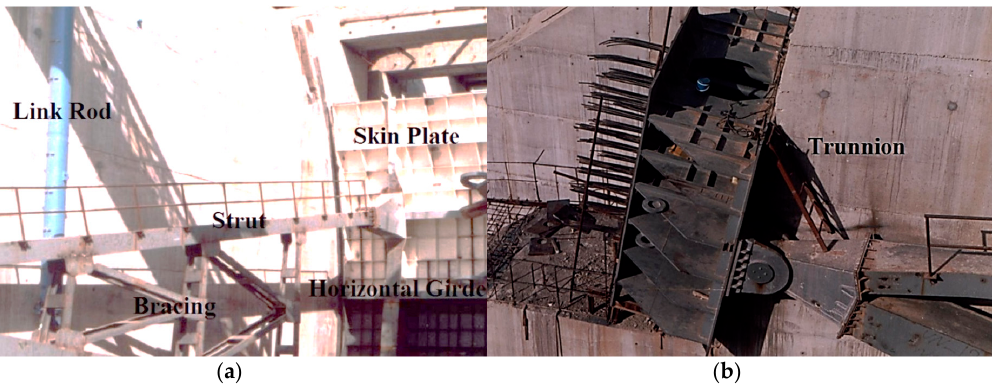
Figure 2. Primary radial gate components of Karkheh Dam ( a ) truss and skin plate, ( b ) trunnion beam. Karkheh dam spillway has six radial gates, each 15 m width with a height of 18.29 m (209 m above sea level); constructed generally for flood control with an overall discharge 18,700 m 3 /s. The structural dimensions of a spillway gate including width, height, skin plate radius, and the location of trunnions have been designed according to specific principles. The location of trunnions has an important function to resist hydrostatic forces. To maintain spillway stability, it is recommended that the hydrostatic resultant force applied to a radial gate possess either horizontal or downward direction to minimize overturn force. Mounting trunnions at one-third radial gate’s height make the direction of resultant force toward the gate horizontal. In general terms, the resultant force tends to be downward for lower trunnion locations. Accordingly, the trunnion locations are recommended to be one-third or half of the radial gate height. Additionally, the skin plate radius has an oppositional relationship with the weight of the gate. A radial gate with a small skin plate radius requires great